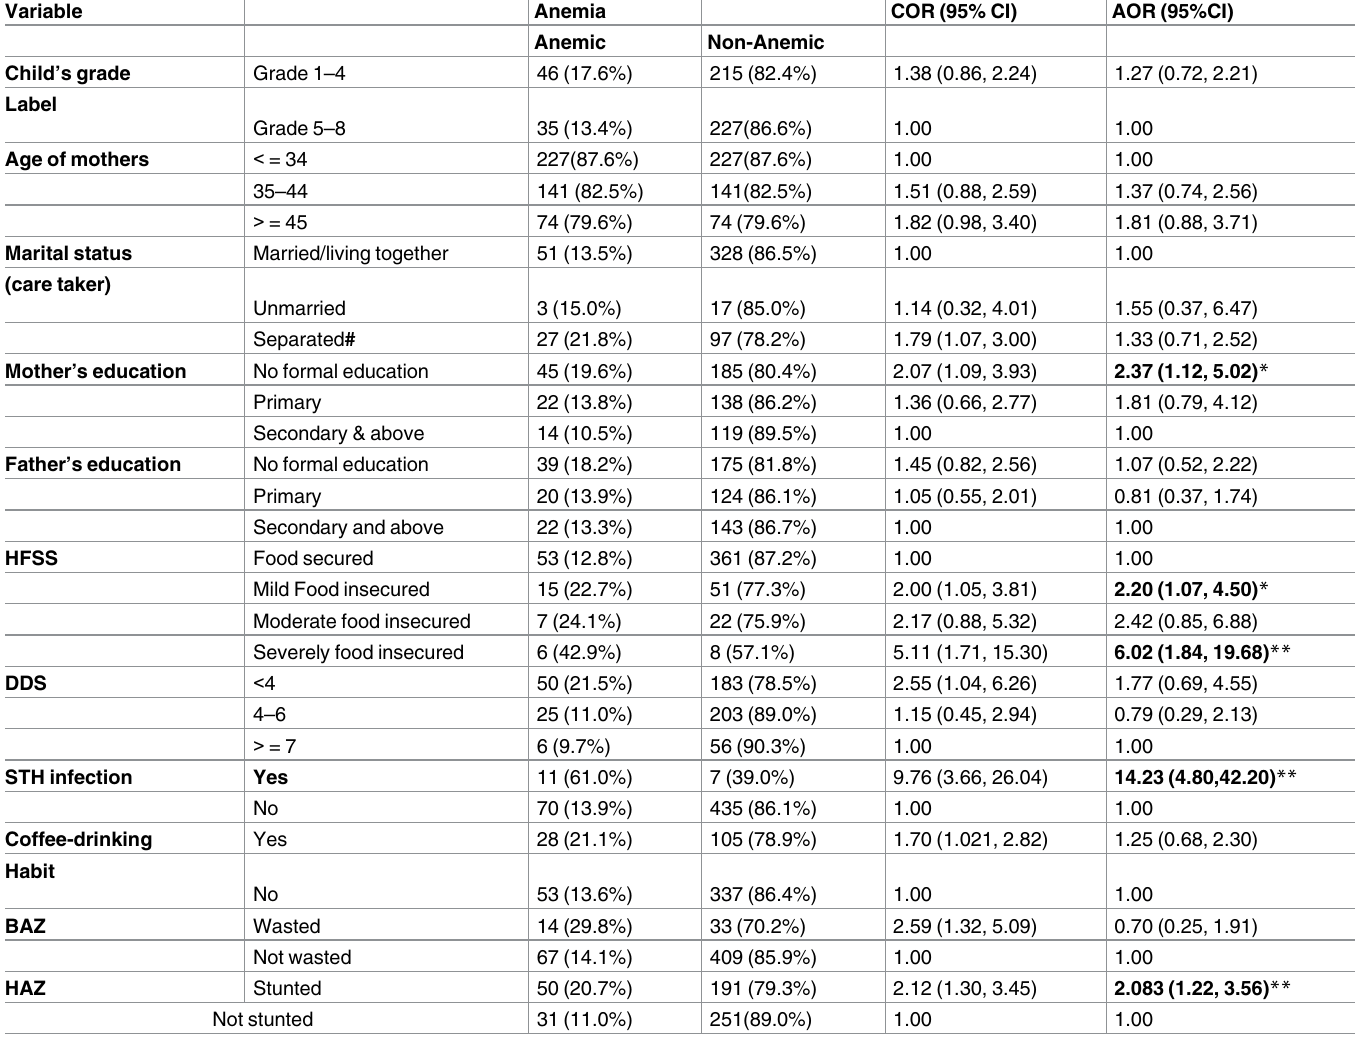
Table 2. Bivariate and multivariate logistic regression analysis of factors associatedwith anemia among SC in Gondar town, northwest Ethiopia, February to May 2017(n = 523).